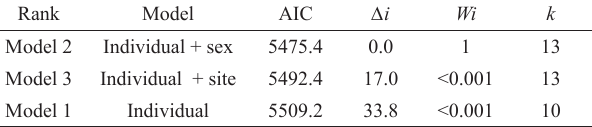
Tab. 3. Results of model selection based on Akaike